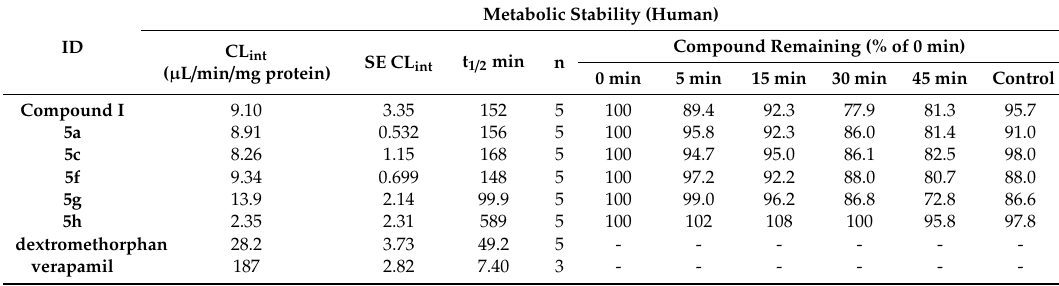
Table 3. In vitro metabolic stability of compounds 5a, 5c, 5f – h compared to control